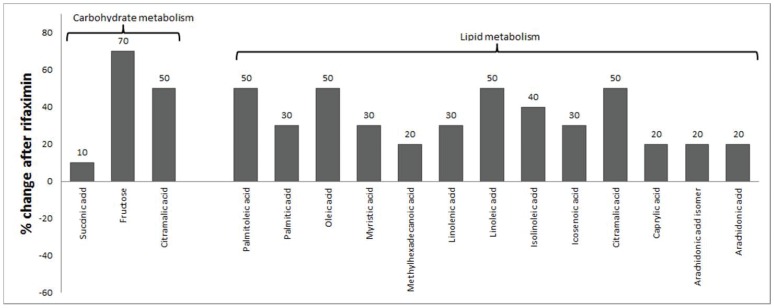
Univariate serum metabolomic analysis.There was a significant increase in fatty acids and intermediates of carbohydrate metabolism after rifaximin therapy in the serum.